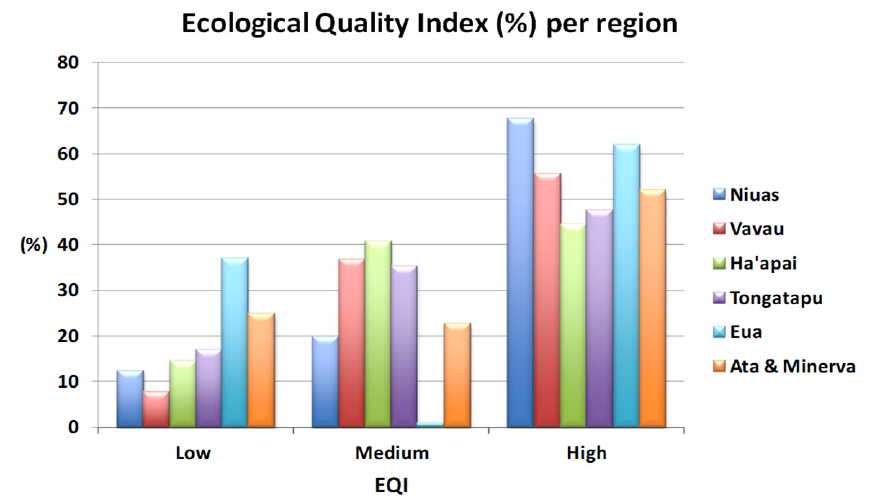
Figure 5. Ecological Quality Index (EQI) percentages calculated for the five Tonga regions, Ata Island and Minerva Reef.